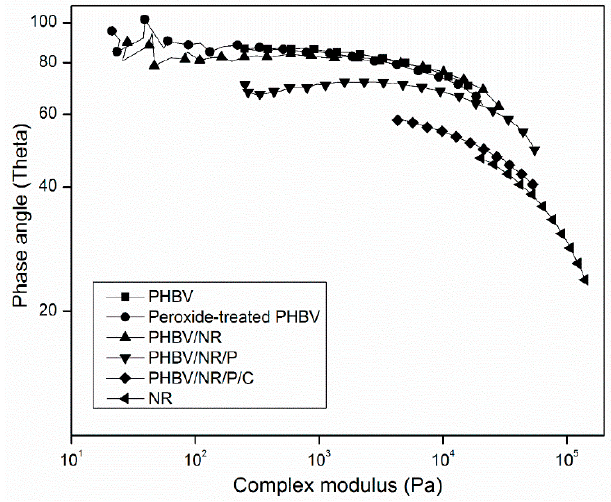
Figure 3. Van Gurp–Palmen plots of pristine PHBV, pristine NR, and PHBV/NR blends.